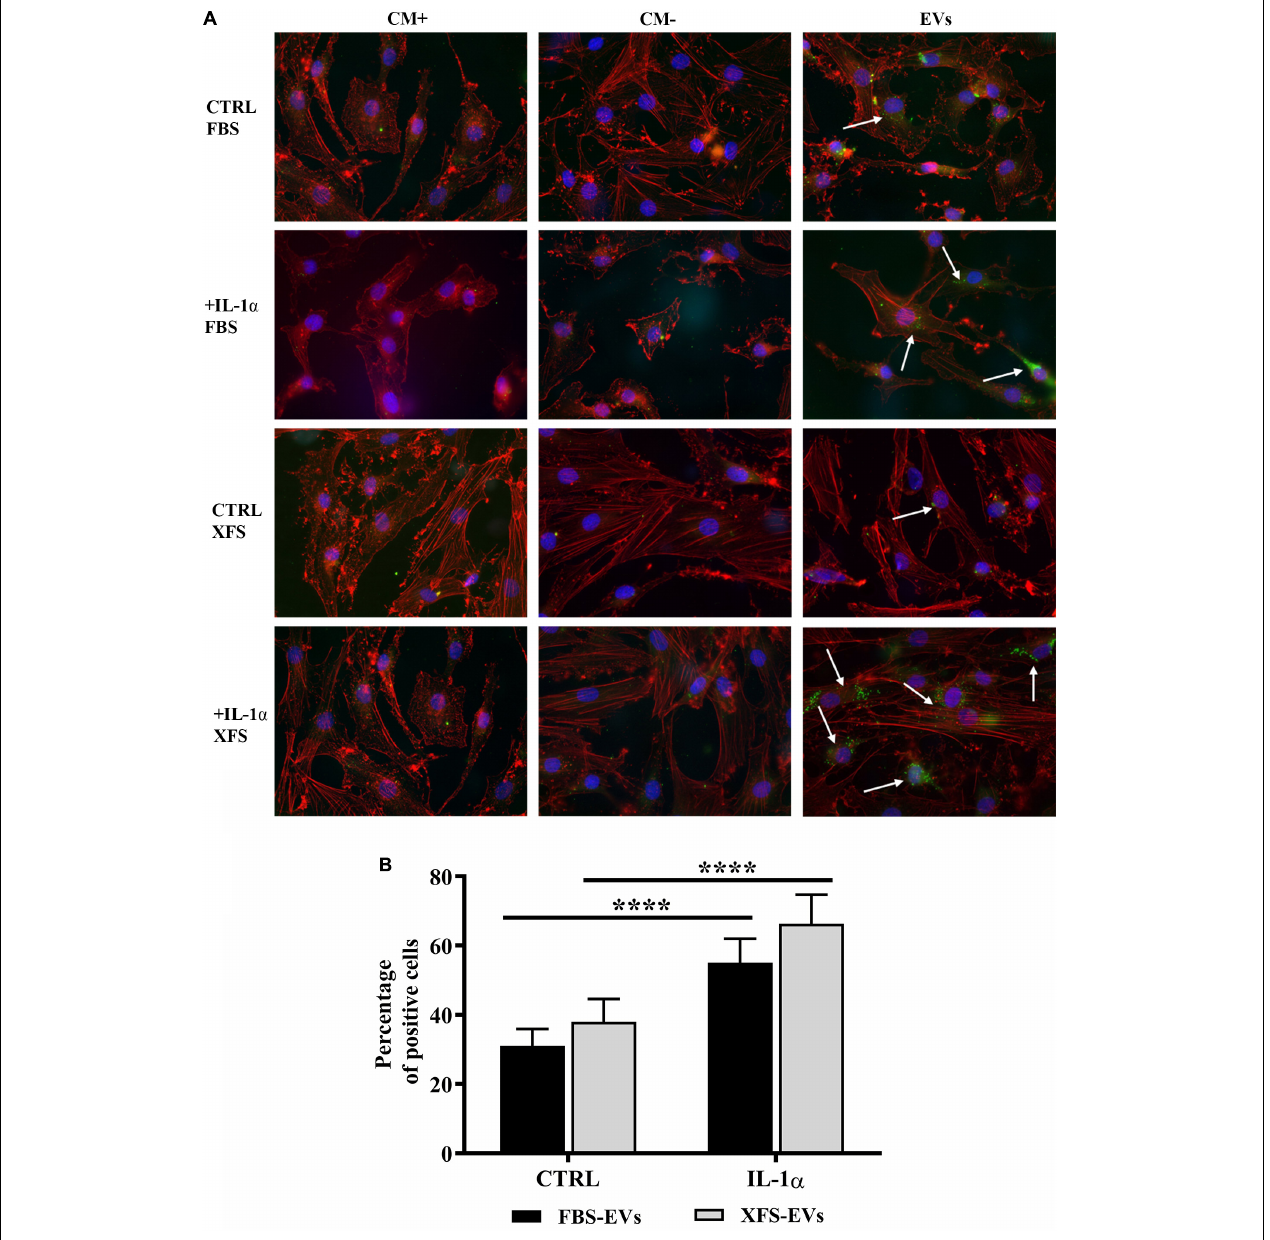
FIGURE 7 | Uptake of EVs from hACs and OA hACs. (A) PKH67-stained hBMSC-EVs uptake by hACs and OA-hACs. (B) Data are represented as mean ± SD and are representative of five independent experiments. Quantification was performed on hACs and OA hACs pre-treated with IL-1 α and then treated with PKH67-stained EVs. Positive cells were counted on at least five different areas for each experiment. **** P < 0.0001, two-way